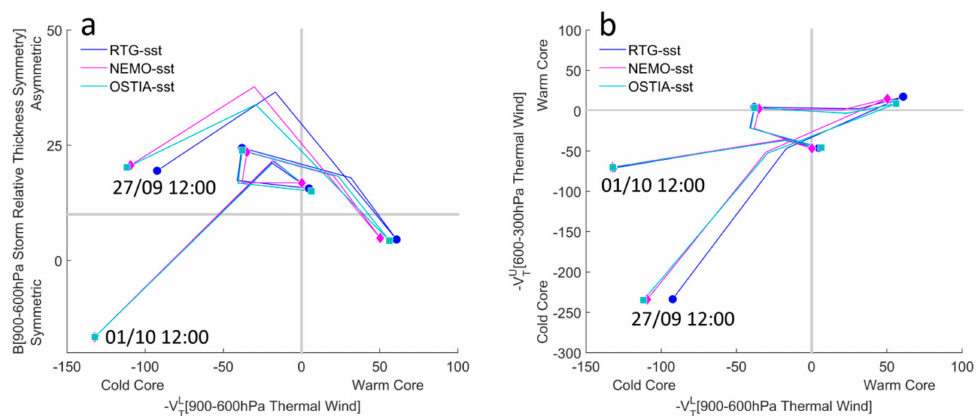
Figure 11. Phase space diagrams of ( a ) − V L vs. − V U (600–300 hPa) evolution from RTG-sst, NEMO-sst, and OSTIA-sst simulations during cyclone T Zorbas. Markers are shown every 12:00